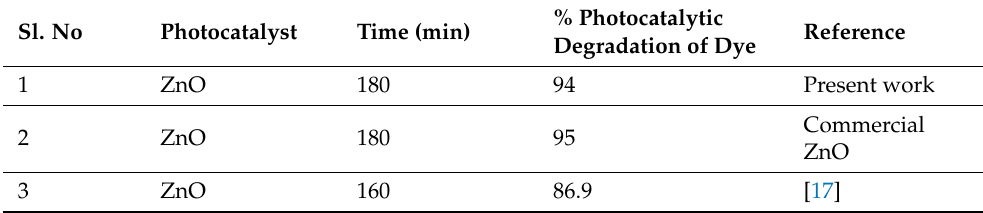
Table 3. Comparison of ZnO-NPs as a photocatalyst for dye